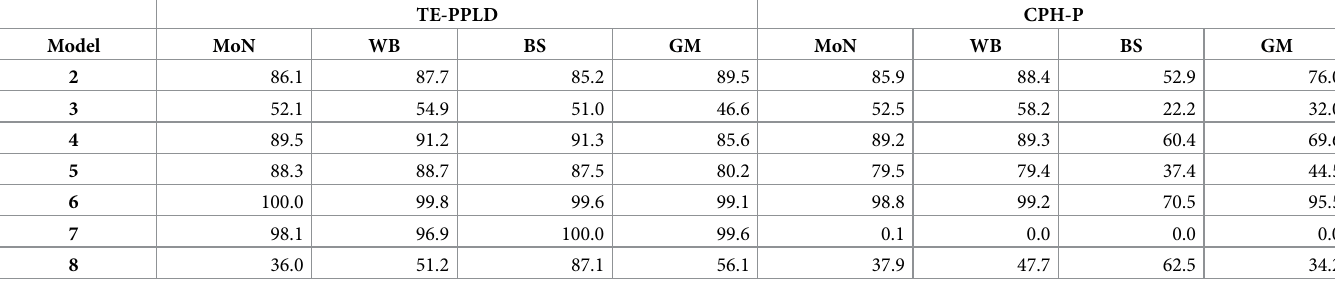
Table 6. Comparative power of TE-PPLD and CPH-P analyses as a function of underlying survival distribution.